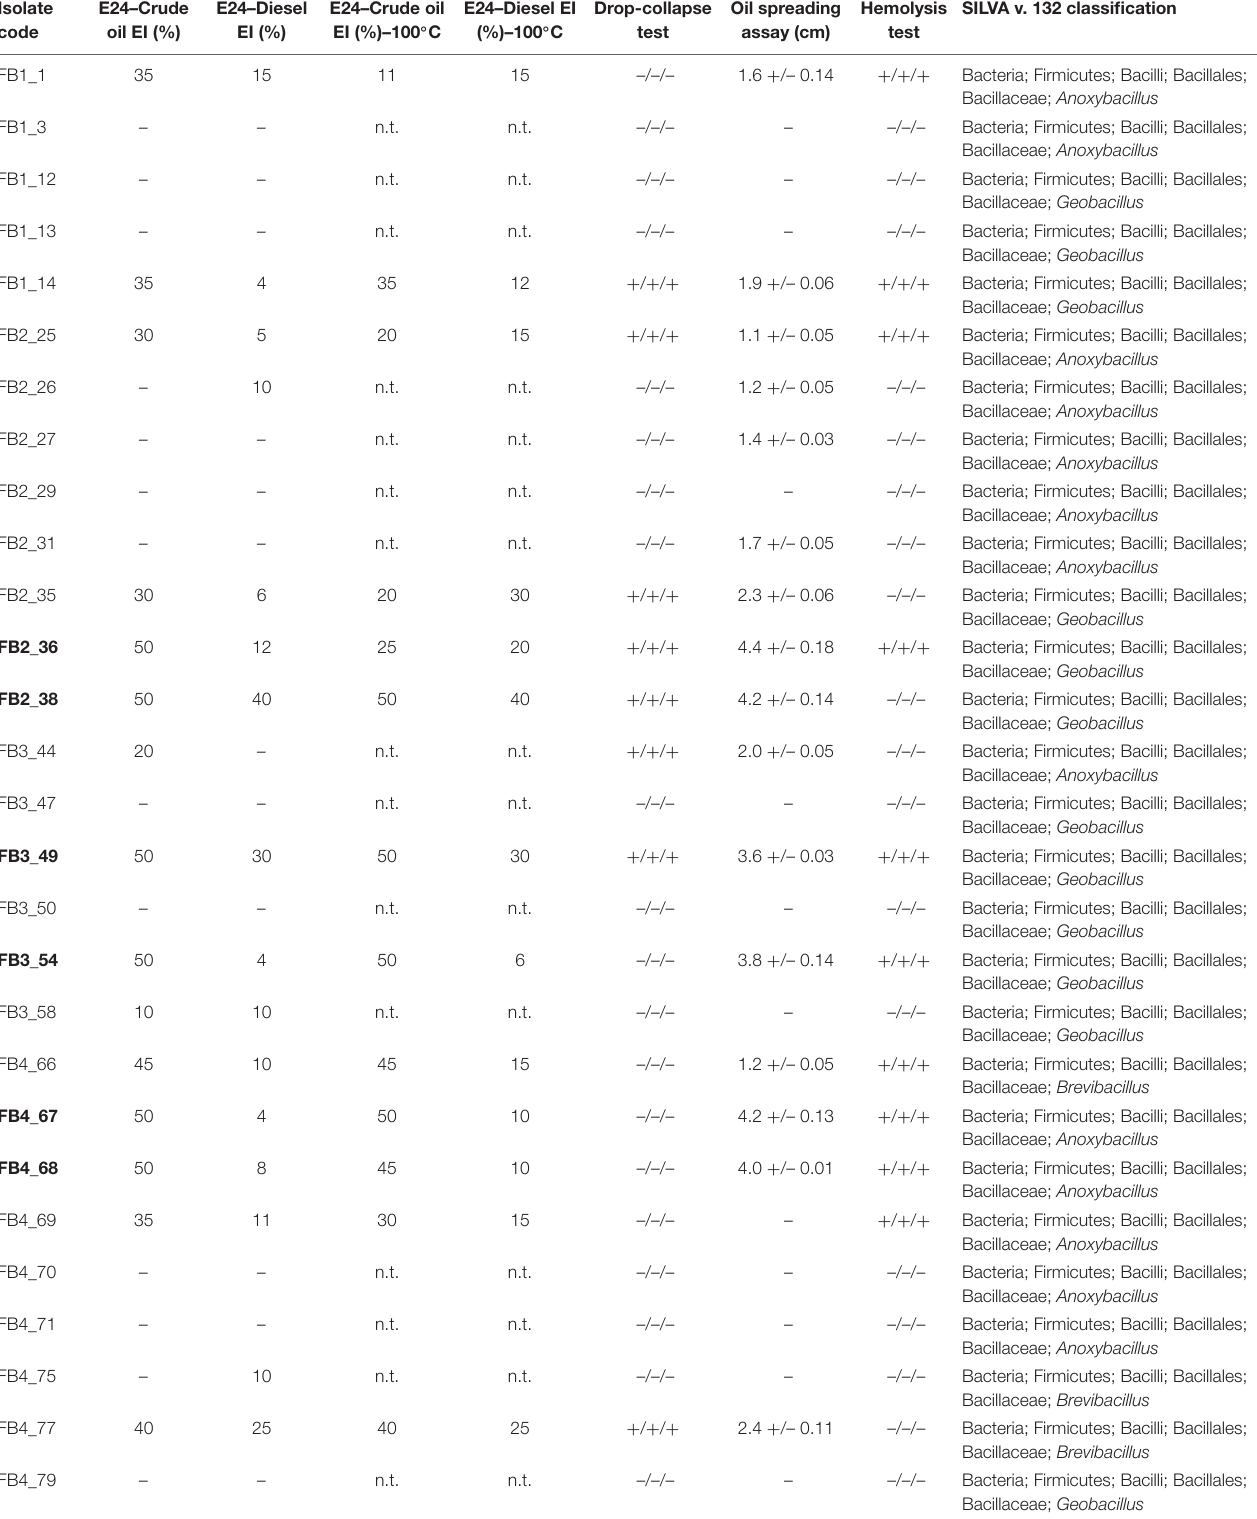
TABLE 2 | Strains isolated from different geothermal sites in Deception Island, their capacity to produce biosurfactants using different methodologies for screening (all in triplicate) and their molecular identification. Isolate